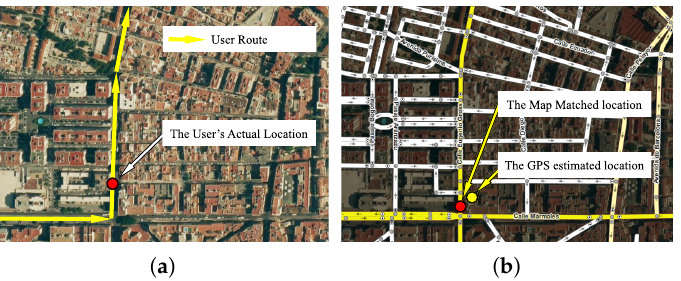
Figure 3. The map-matching problem. ( a ) Map of actual streets; ( b ) Digital Map and map-matching result.